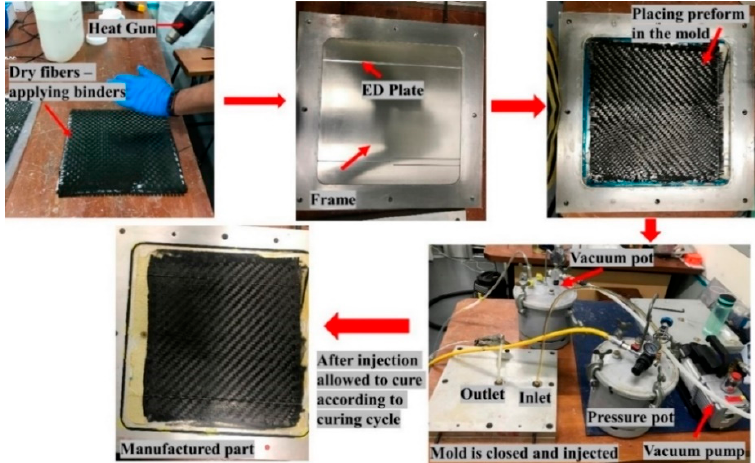
Figure 2. Manufacturing steps during the Resin Transfer Moulding (RTM) of composite laminate.